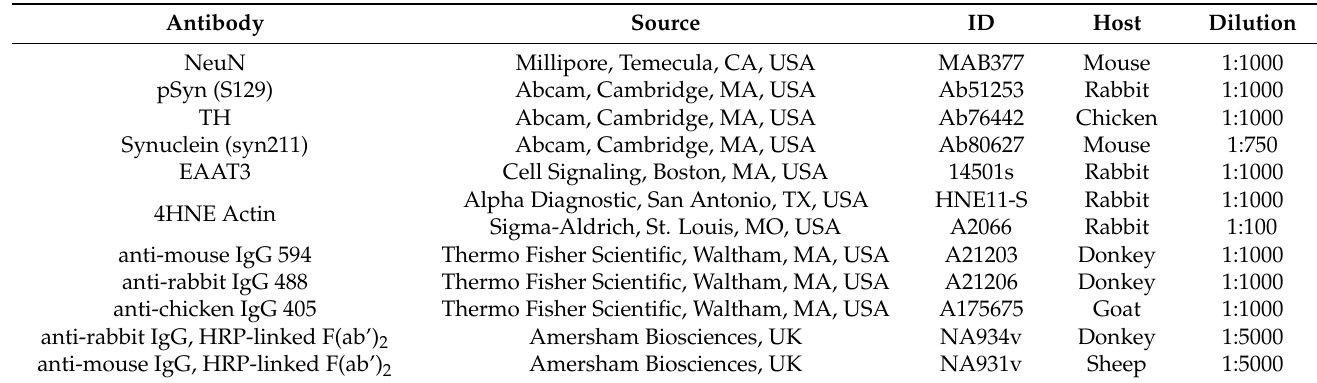
Table 2. Primary antibody sources and dilutions